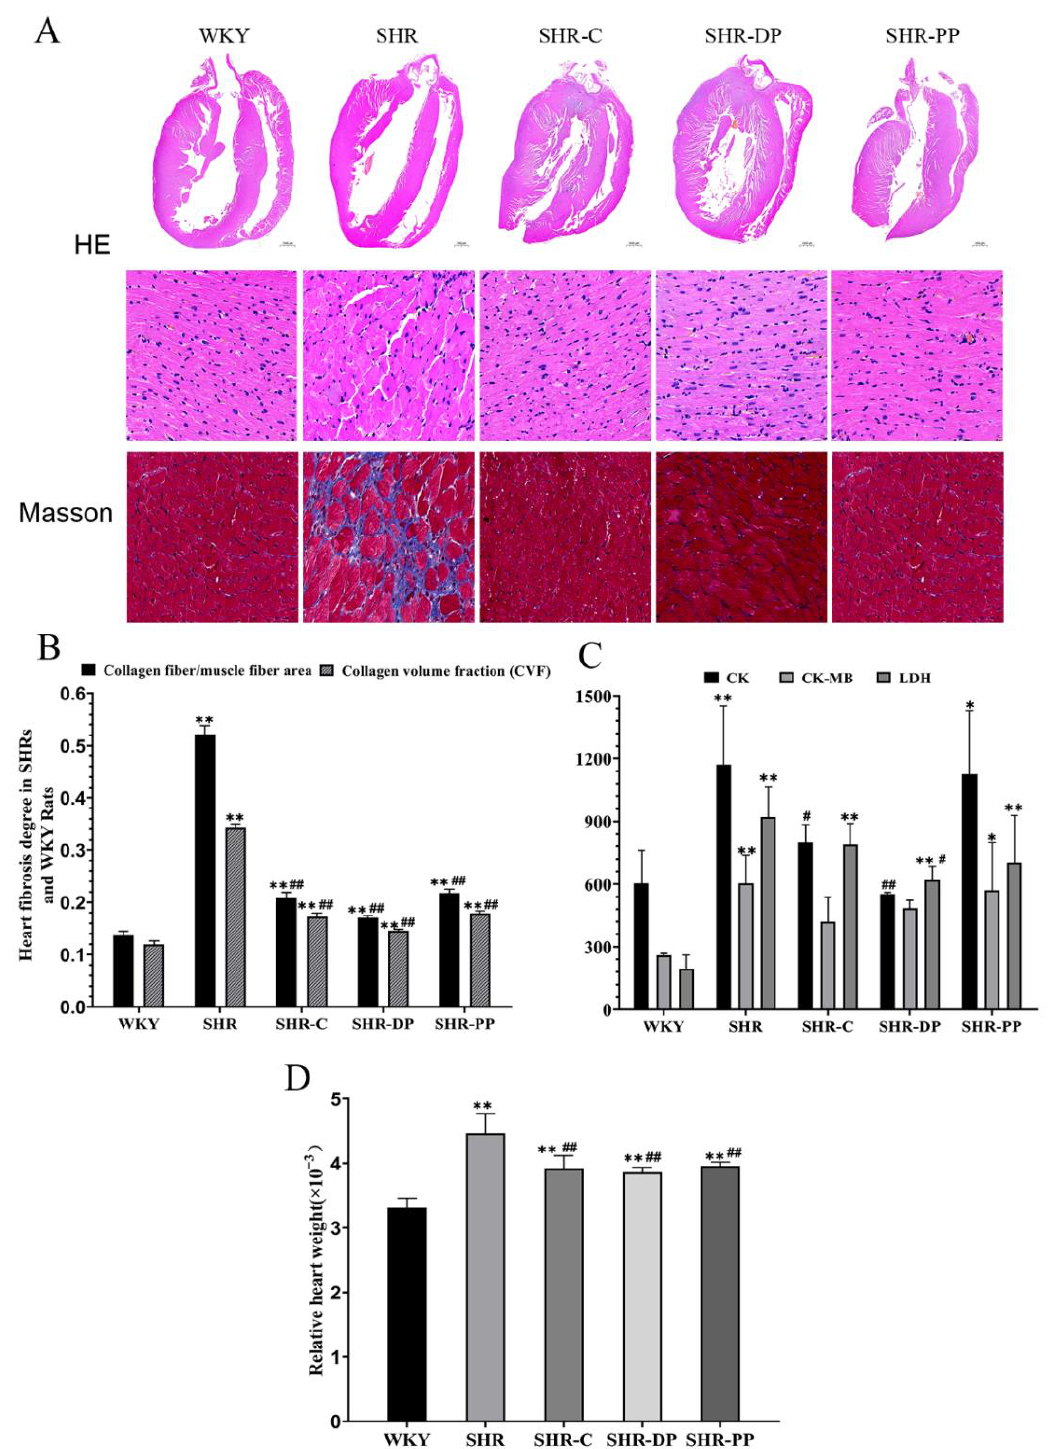
Figure 4. The influence of heart structure and damage to rats in each group after pea peptides and two-peptide composite intervention. ( A ) The representative micrographs of rat heart with the HE staining (0.8× and 40×) and Masson staining (50×); ( B ) Degree of heart fibrosis in rats of each group; ( C ) Serum concentration of heart function-related markers (CK, CK-MB and LDH); ( D ) The relative organ weight of heart. The data in the figure are expressed as mean ± SEM. * p < 0.05, ** p < 0.01, represents the difference from the WKY group, respectively; # p < 0.05, ## p < 0.01, represents the difference from the SHR group, respectively.